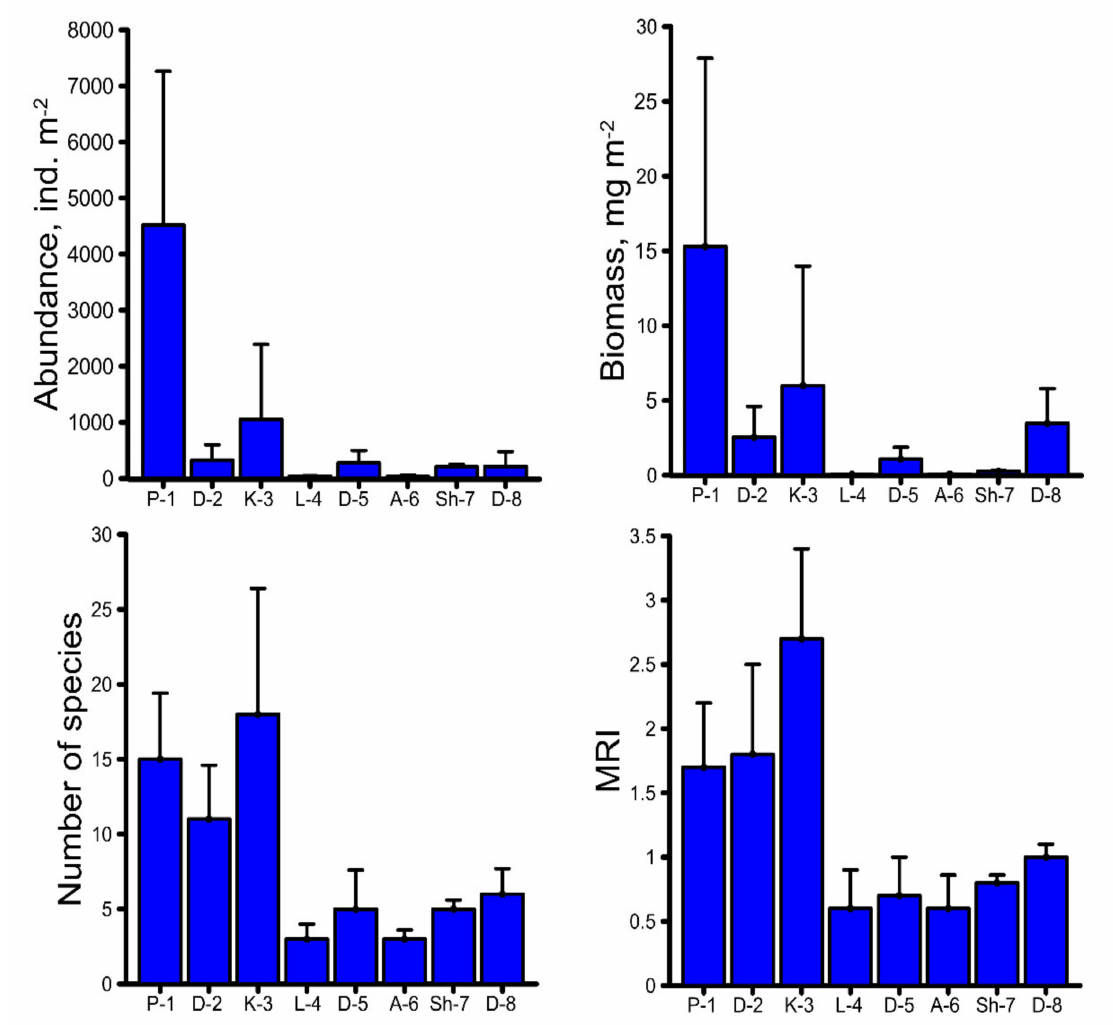
Figure 4. Spatial distribution of the average values of macrozoobenthos parameters in the rivers of the Debed catch- ment